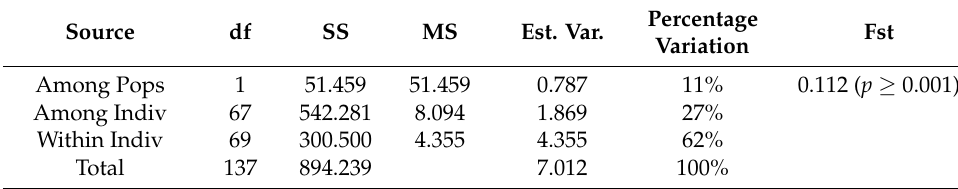
Table 5. Summary AMOVA